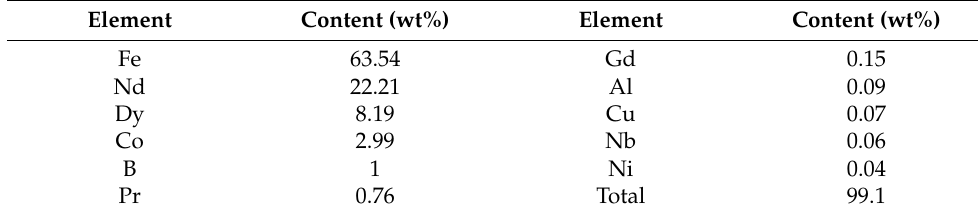
Table 1. The composition of the N35 NdFeB magnet.